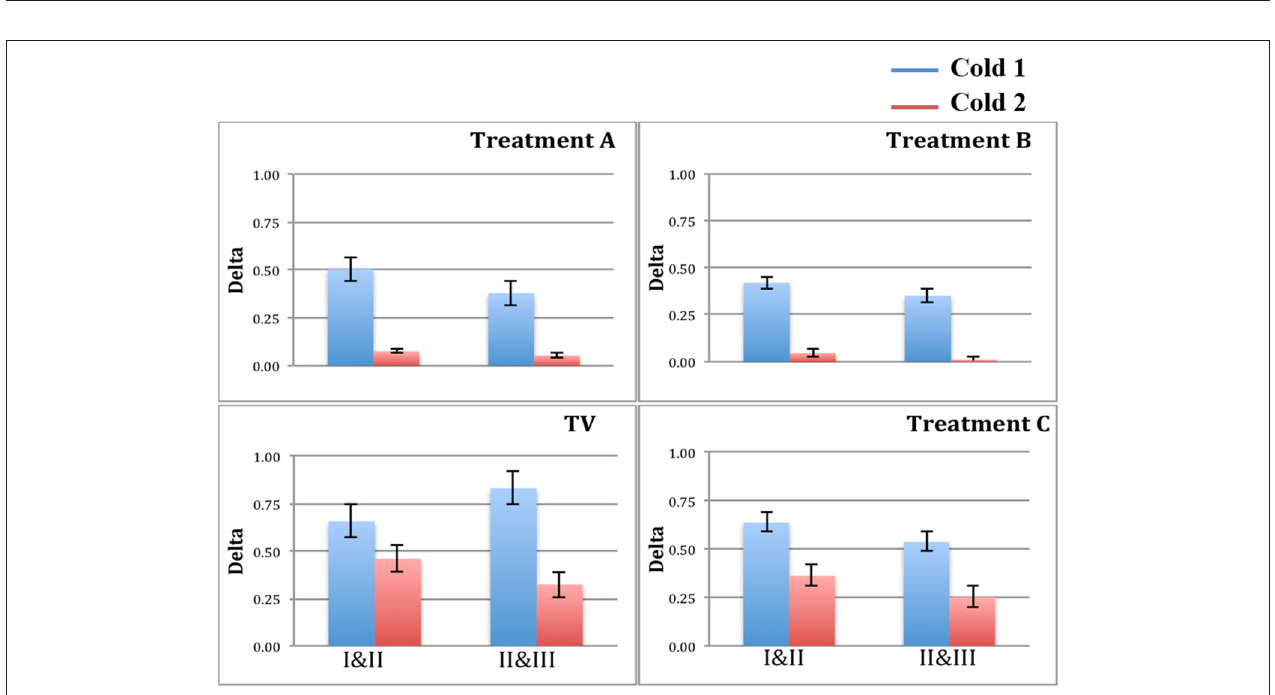
FIGURE 5 | Blue bars = delta values between regions for Cold1. Red bars = delta values between regions for Cold2. Treatments A and B show a significant reduction in the deltas, as hypothesized for these two analgesics.